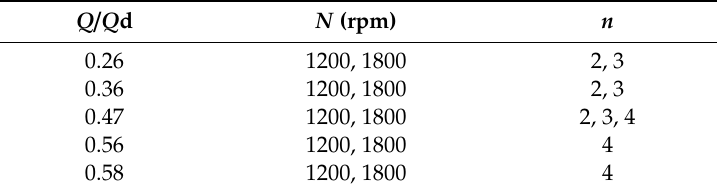
Table 4. Identified stall modes in the